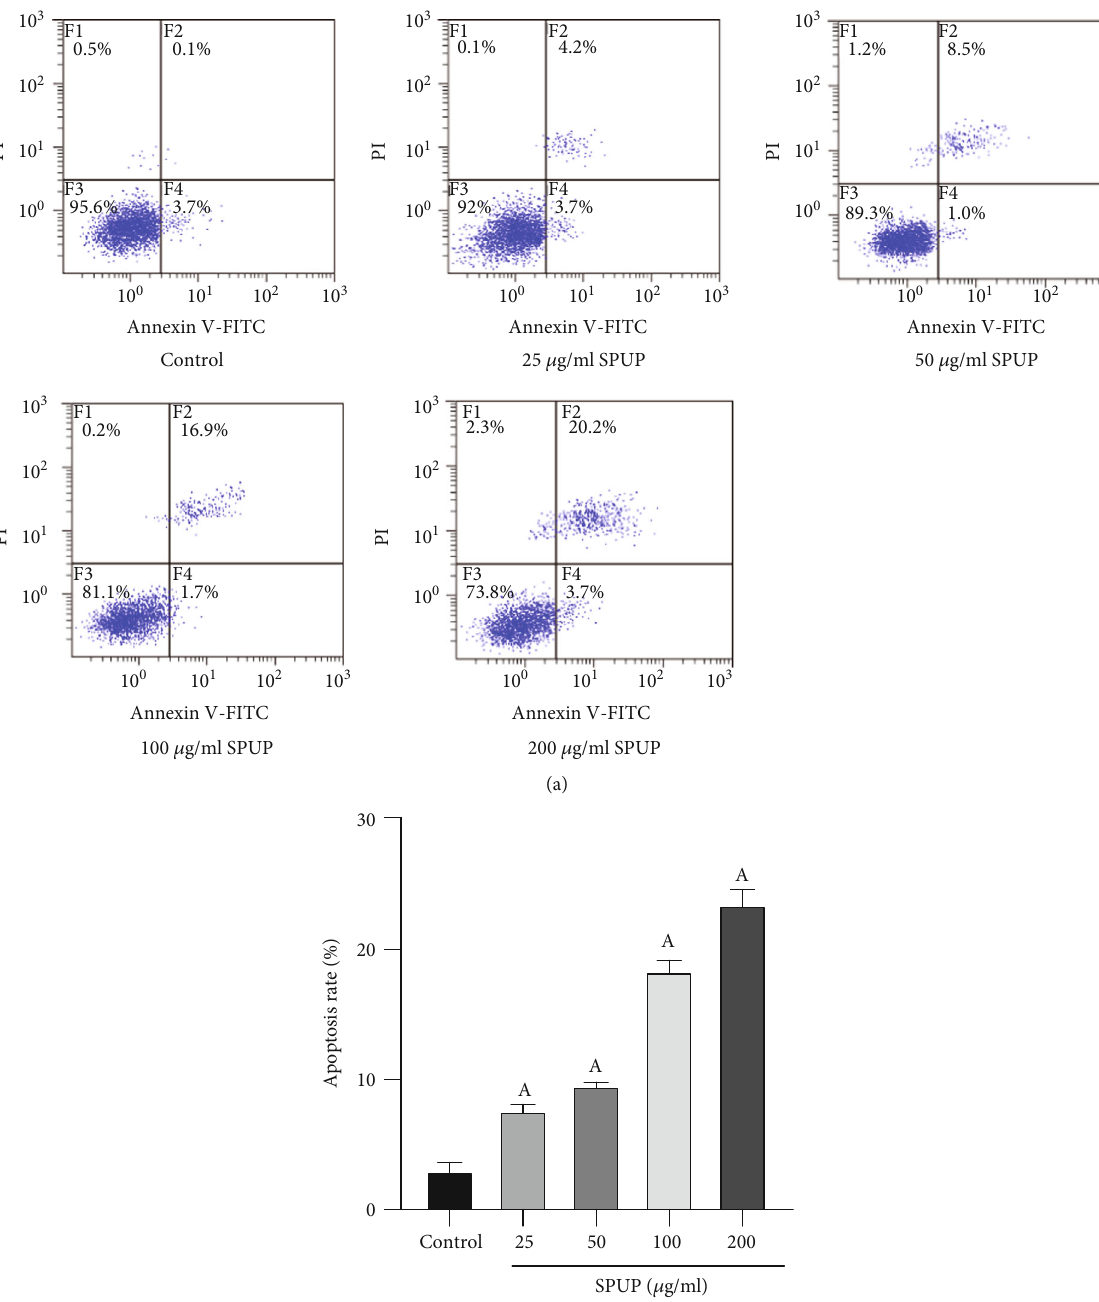
Figure 5: E ff ect of SPUP on the apoptosis of DU145 cells. Compared with the control group, A: <